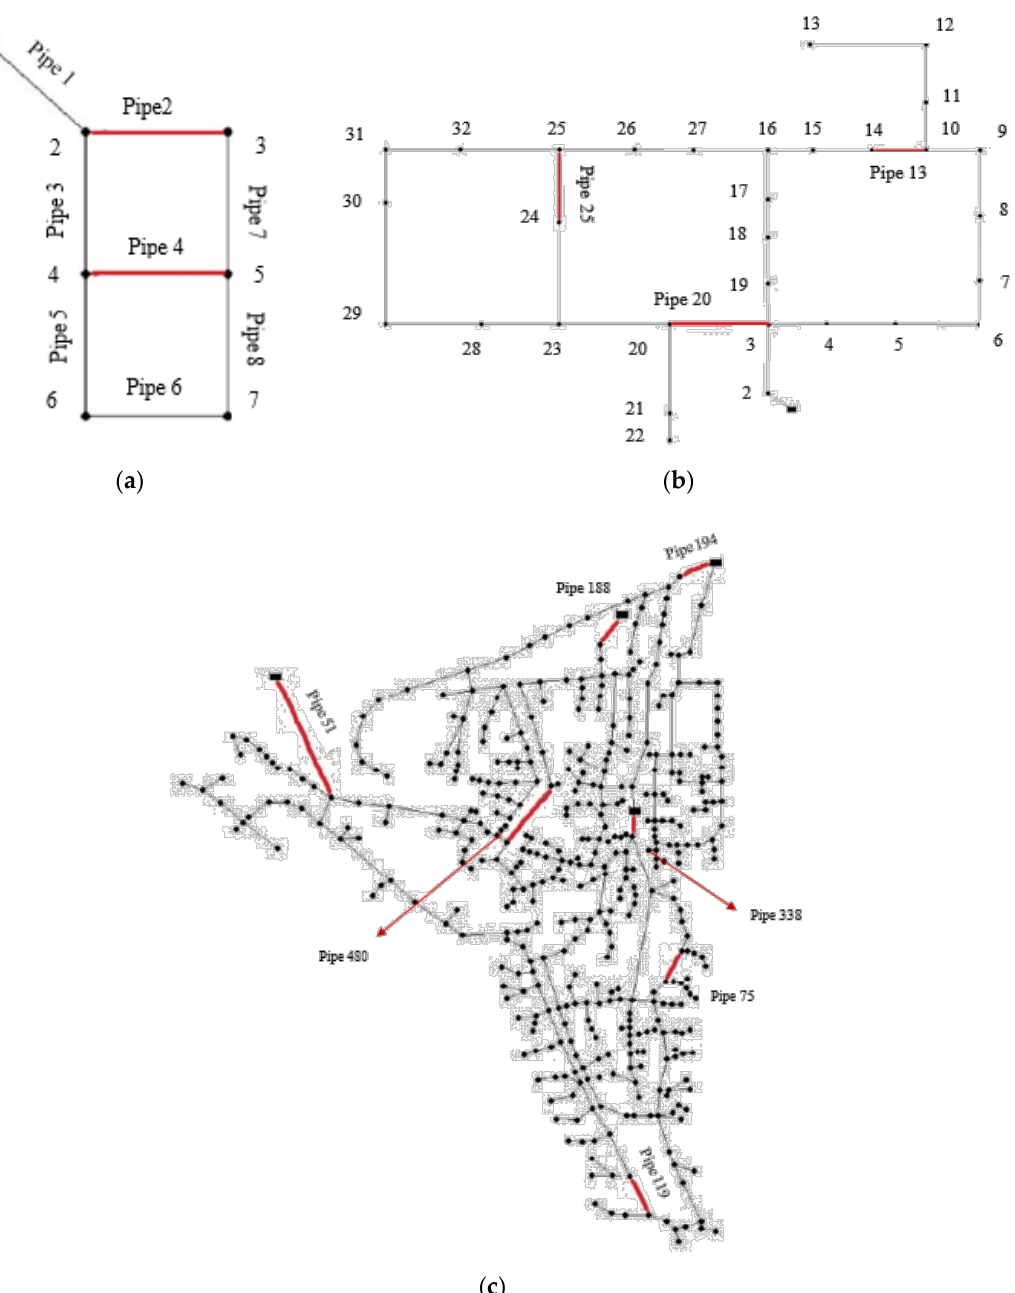
Figure 6. Pipe failures in the TLN ( a ), HAN ( b ) and BIN ( c ). Table 6. Characteristics of closed pipes.